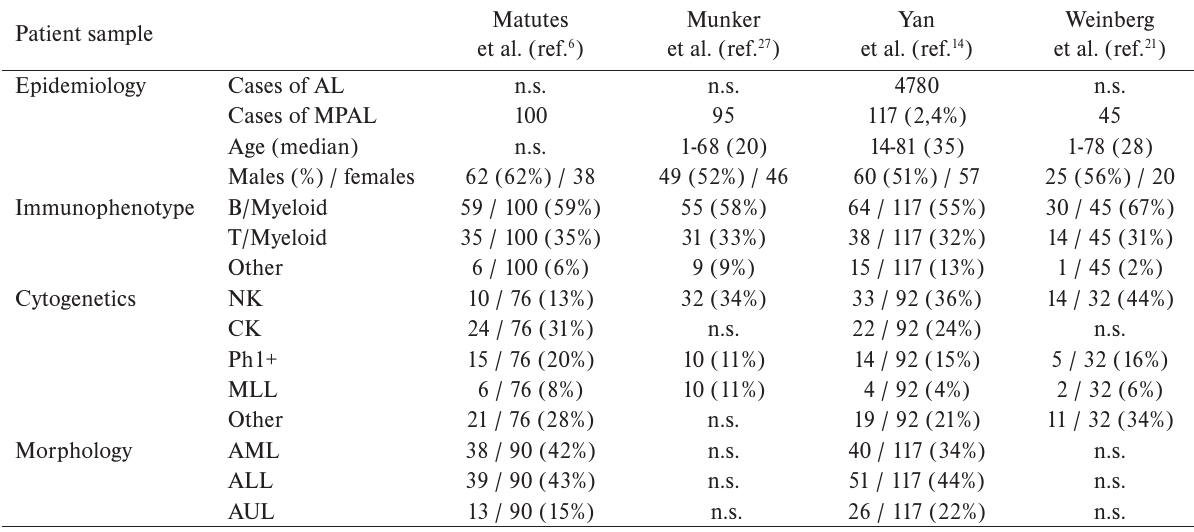
Table 4. Overview of selected samples of patients with MPAL (according to the 2008 WHO criteria). Patient